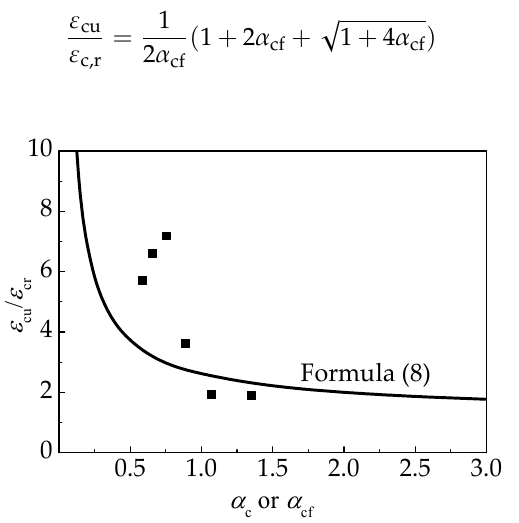
ε / ε α / α cu c,r and c c,f